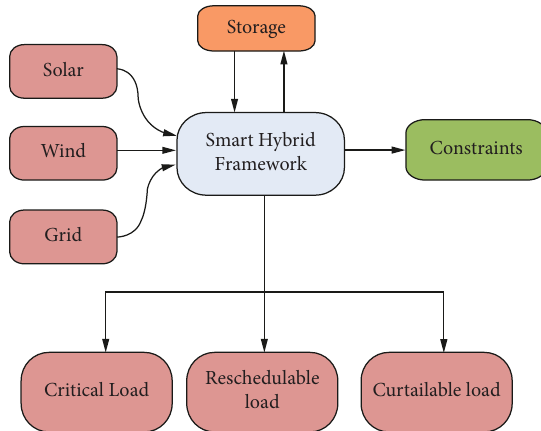
Figure 4: Te block diagram of the proposed framework.